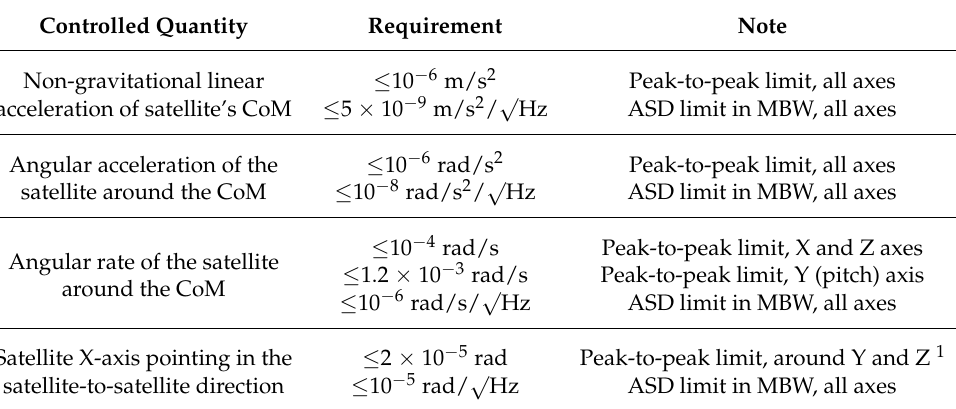
Table 4. Requirements on non-gravitational accelerations and attitude motion control for NGGM. Controlled